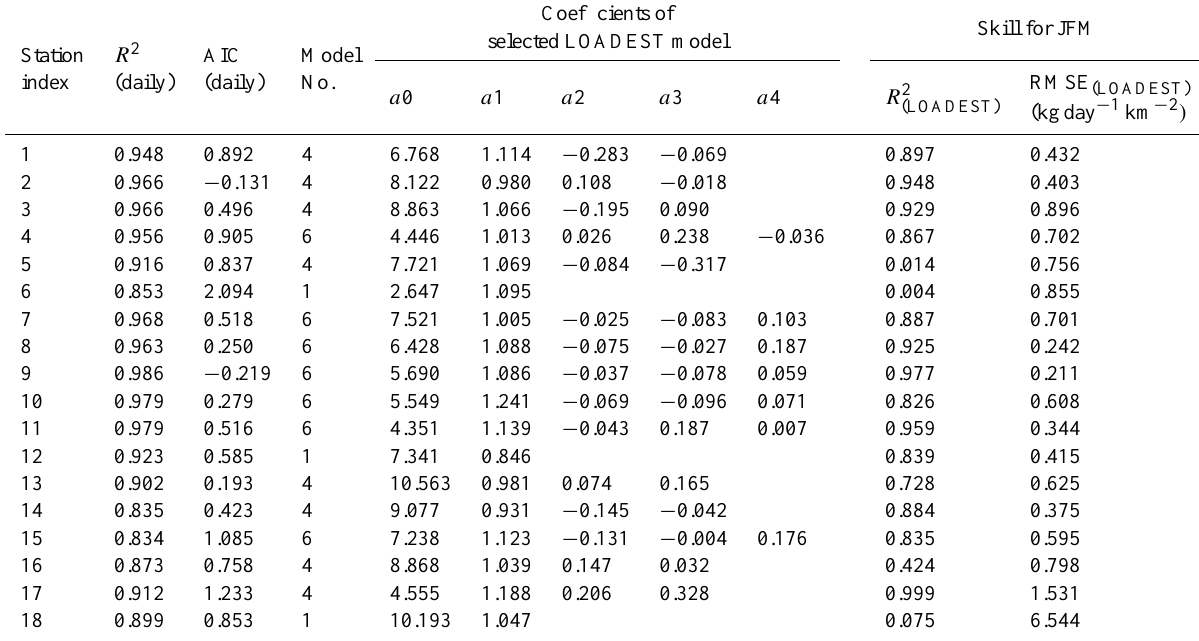
Table 2. Performance of LOADEST model in predicting the observed TN loadings from the WQN database. Models with linear time components (Model No.: 3, 5, 7–9) are not considered. The skill in predicting JFM WQN loadings is separately given in the last two